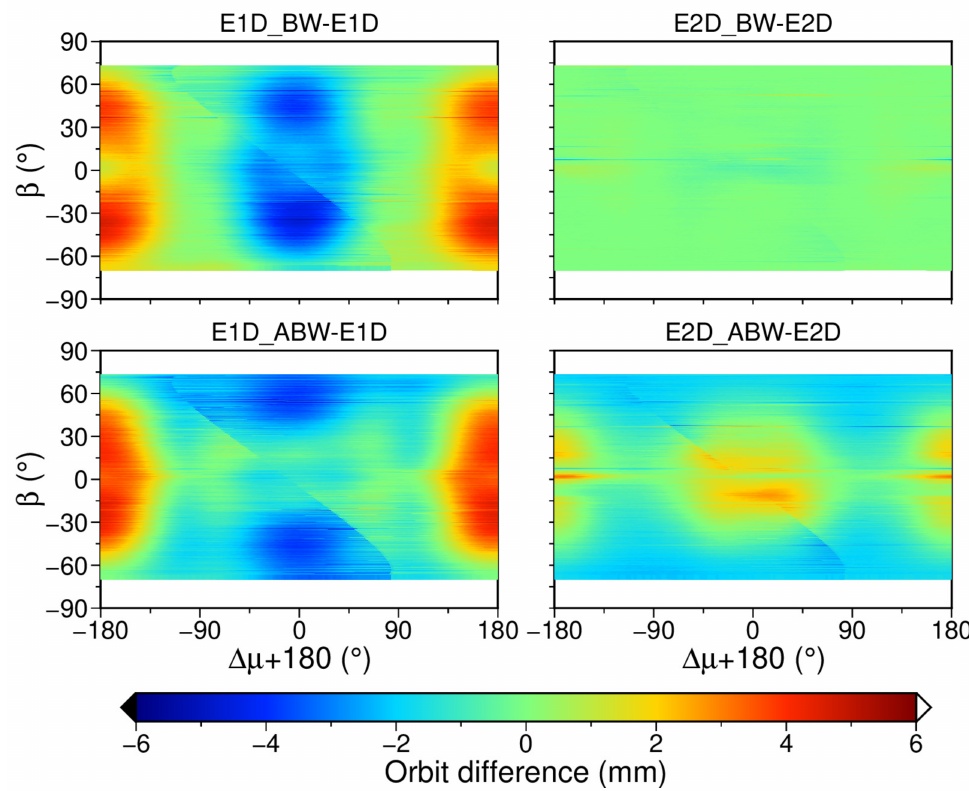
Figure 9. Differences of satellite orbit in the radial component between solutions using different a priori models for SVN G050 (BLOCK IIR) as a function of β and ∆ µ angle in 2019. ∆ µ is the angular argument. Upper: differences between using no a priori SRP model and using the box-wing model; lower: differences between using no a priori SRP model and using the adjustable box-wing model. Left and right panels: using the ECOM1 and ECOM2 as the parameterization model,